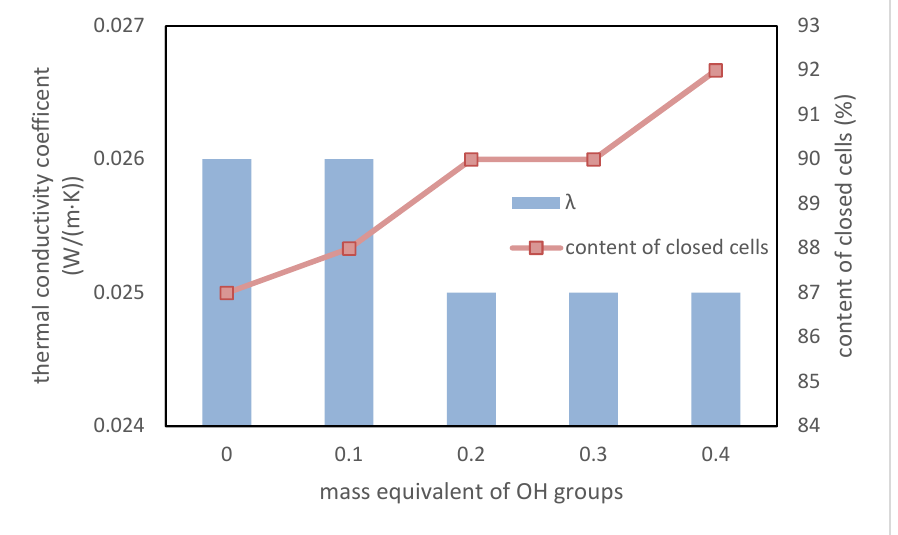
Figure 10. Dependence between EPB content, thermal conductivity coefficient, and content of closed cells.